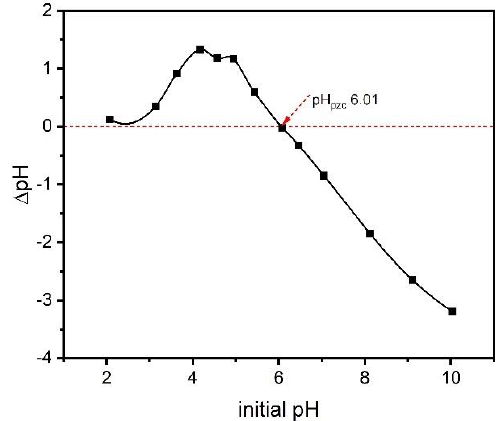
Figure 4. The pH pzc of ABC.